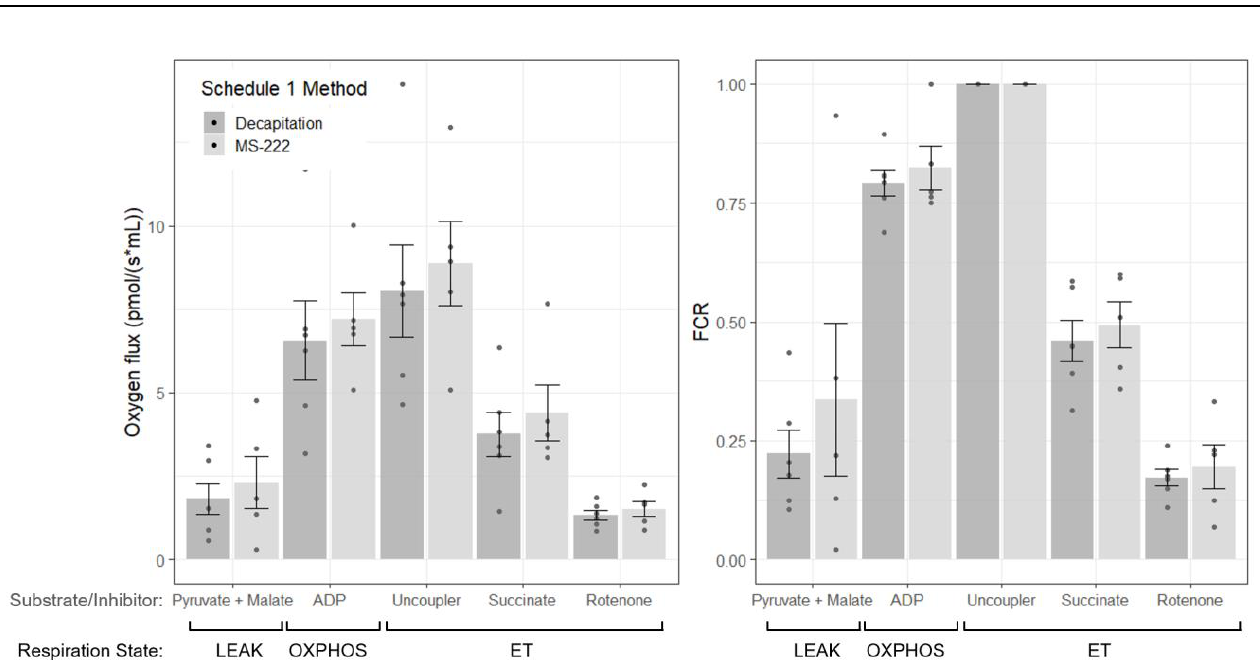
Figure 3. Mean oxygen flux and flux control ratios at LEAK, OXPHOS and ET respiration states in the skeletal tail muscle of the stickleback with complex I substrates (pyruvate and malate) and complex II substrates (succinate). Average values per sample shown by points, n = 7 for decapitation (darker grey), n = 6 for MS-222 treated (lighter grey), excluding those where significant membrane damage was detected. Error bars show standard error. No significant differences ( p < 0.05) were found between treatment groups in either the oxygen flux or FCRs (unpaired Student’s t -test).